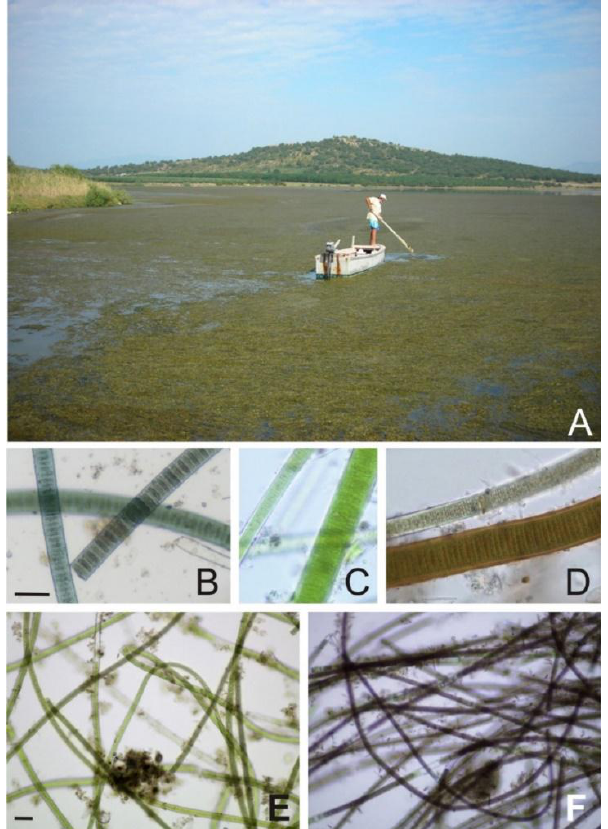
Figure 1. ( A ): An overview of Limnoraphis ( Lyngbya ) heavy bloom in Lafri coastal lagoon, in June. ( B – F ): Light micrographs of Limnoraphis ( Lyngbya ) filament morphology and coloration in the bloom biomass. Scale bars 20 μm for ( B – D ) and 30 μm for ( E , F ).